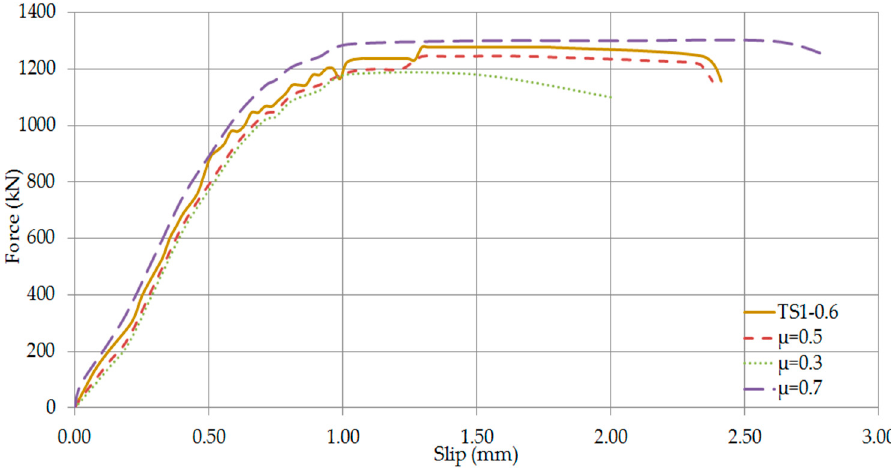
Figure 24. Axial force—Slip Curves of TS1-0.6 (Comparison of friction coefficients).